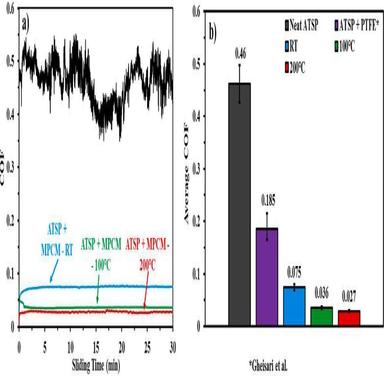
Comparison of COF for (a) in-situ monitoring and (b) average COF values of neat ATSP, ATSP + PTFE, and ATSP + MPCM at RT, and ATSP + MPCM at 100 and 200 ◦C.